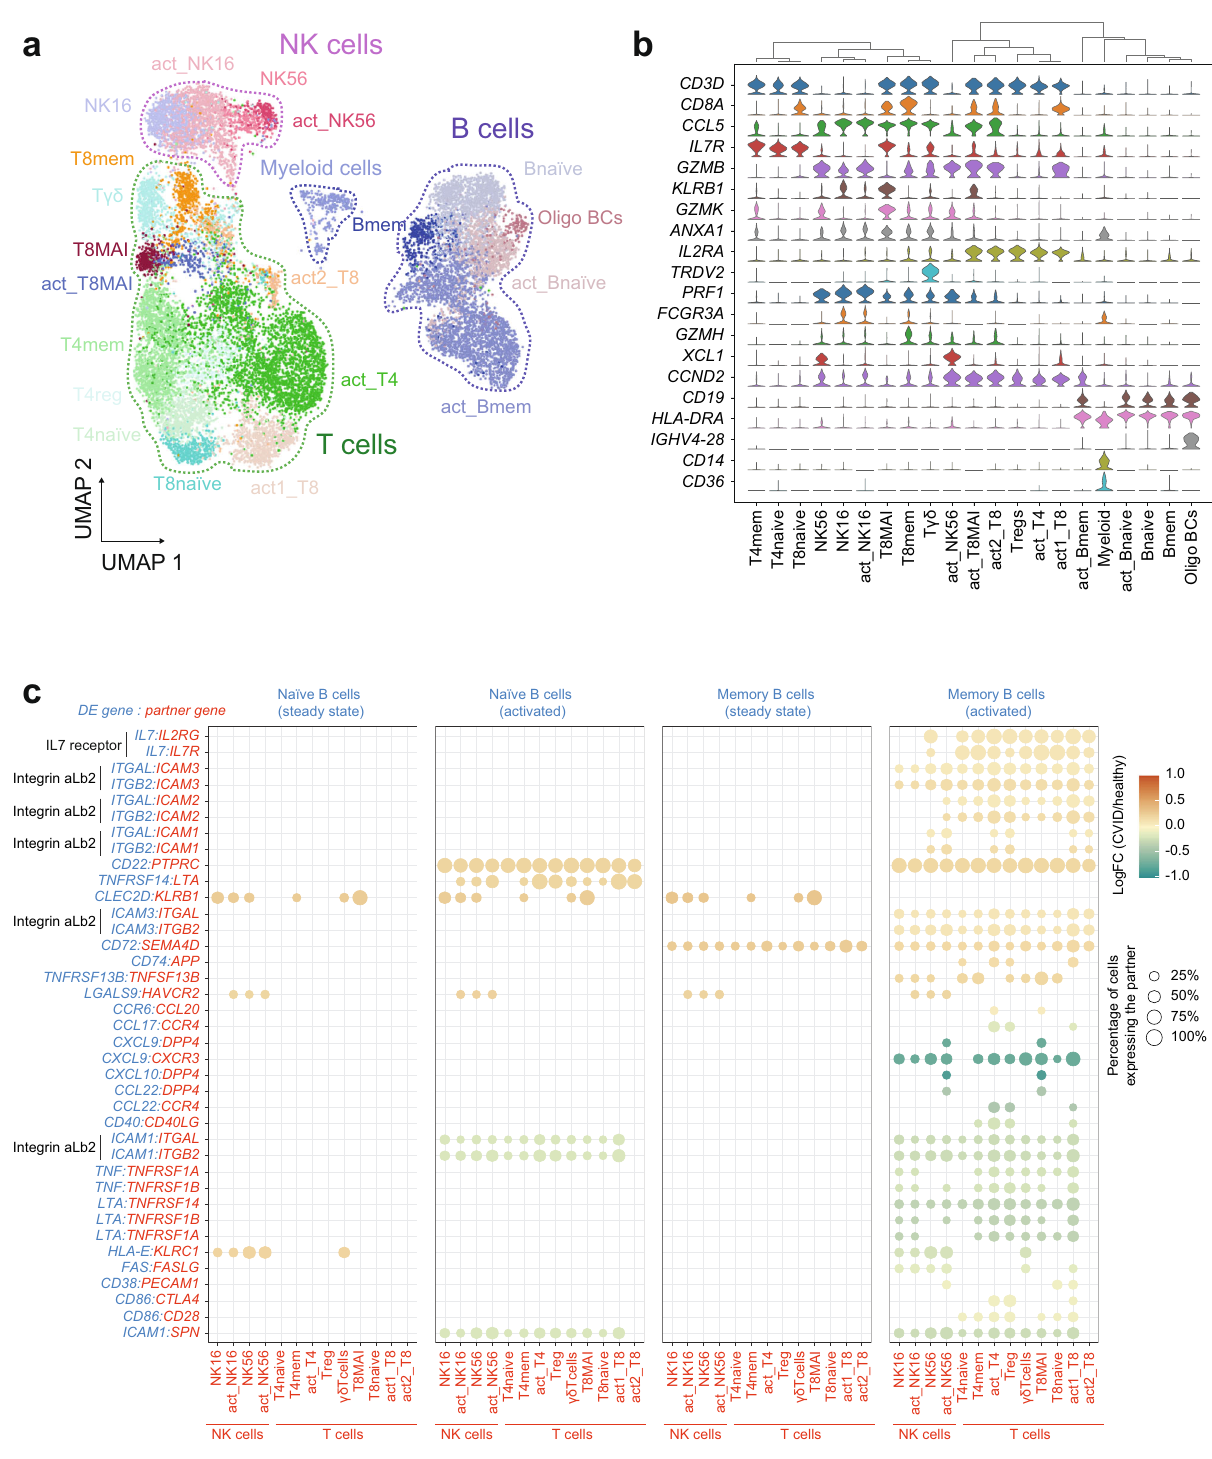
might constitute a repressive autocrine/paracrine mechanism affecting B-cell activation in the CVID twin (Supplementary Fig. 6b). Conversely, we also observed that several genes, like CD86 and the chemokine genes CXCL10 , CCL22 , and CCL17 , were signi fi cantly downregulated in CVID B cells. These cytokines presented their receptor partners in both NK and T-cell subsets (Fig. 5c). We also found expression changes in other cell compartments that interact with B cells (Supplementary Fig. 6c and Supplementary Data 8). For instance, in the CD4 + T-cell compartment, we observed signi fi cant downregulation